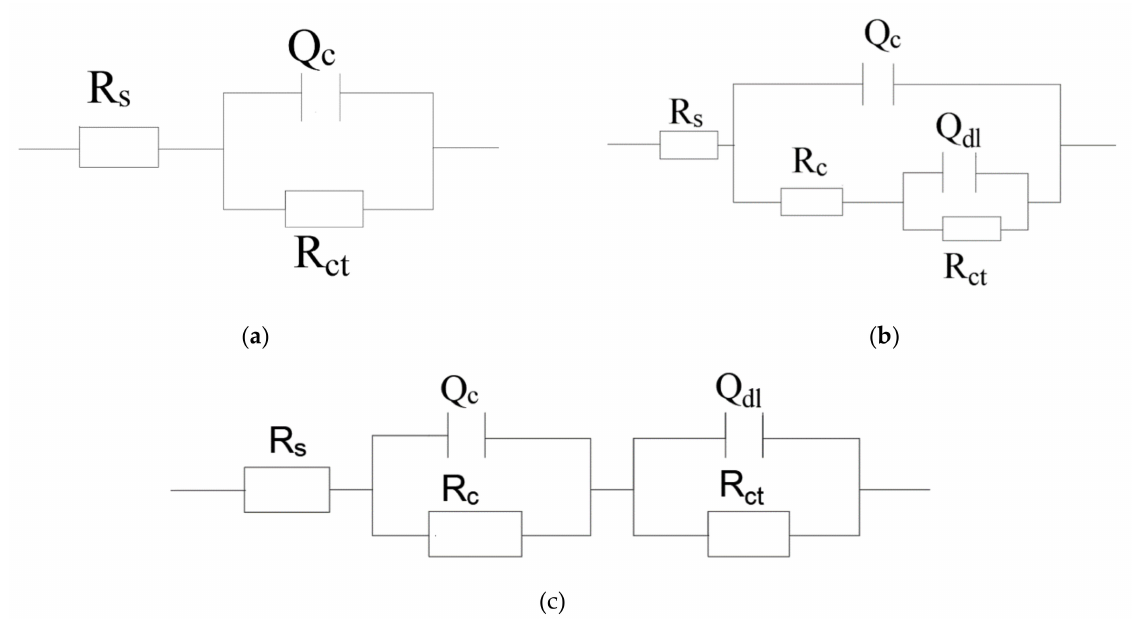
Figure 9. Equivalent circuit: ( a ) one-time constant model and ( b ), ( c ) two-time constants